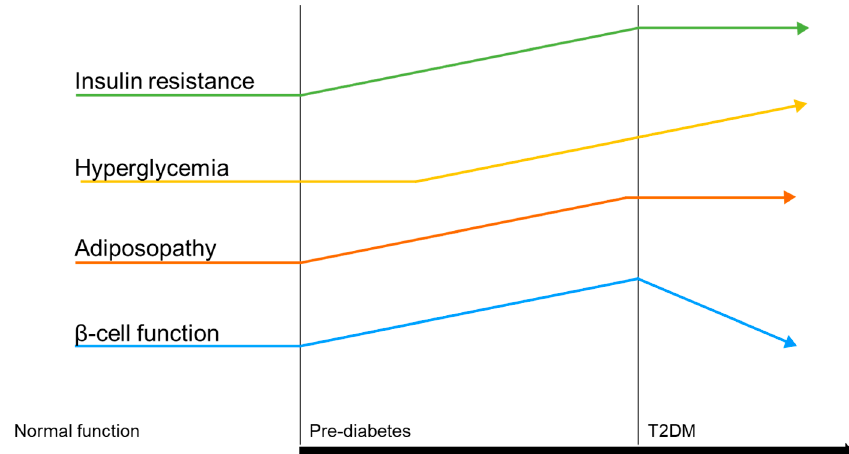
Figure 2. Illustration of the pathophysiological disease drivers in